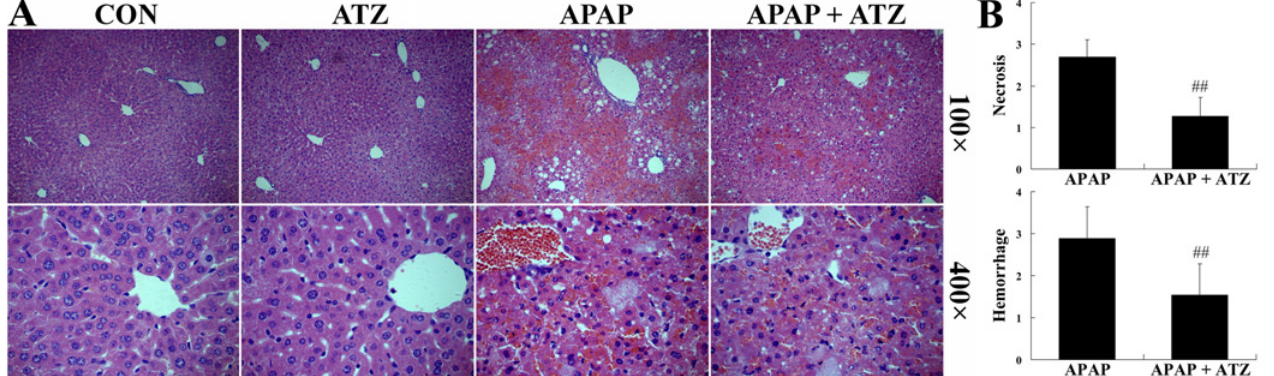
Fig 2. Pretreatment with ATZ alleviated liver histological abnormalities induced by APAP. Liver samples were harvested at 8 h after APAP exposure and the liver sections were stained with hematoxylin-eosin for morphological evaluation. (A) The representative liver sections of each group are shown. (B) The degree of hepatocellular necrosis and hemorrhage were semi-quantified using a 0 (no lesion) to 4 (severe change) scoring system in 20 random fields at 100× magnification per animal (n = 3 per group). Data were expressed as mean ± SD, ## P < 0.01, as compared with the APAP group.